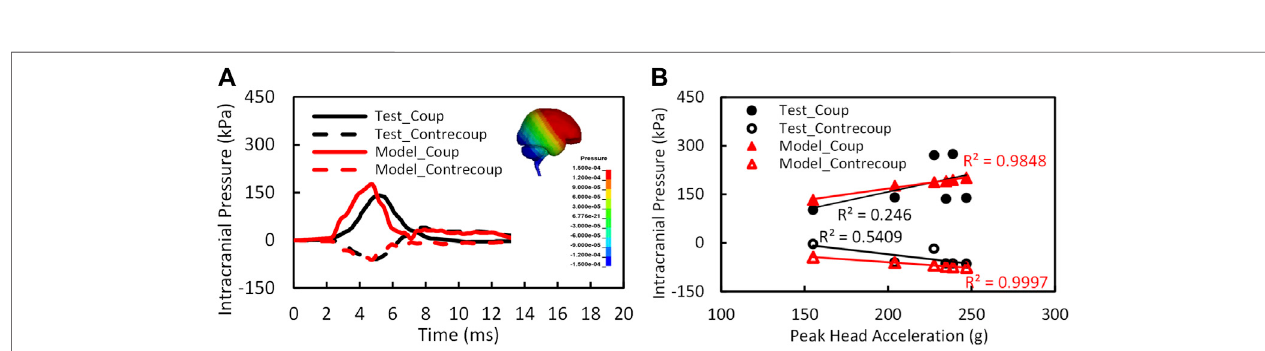
Frontiers in Bioengineering and Biotechnology |